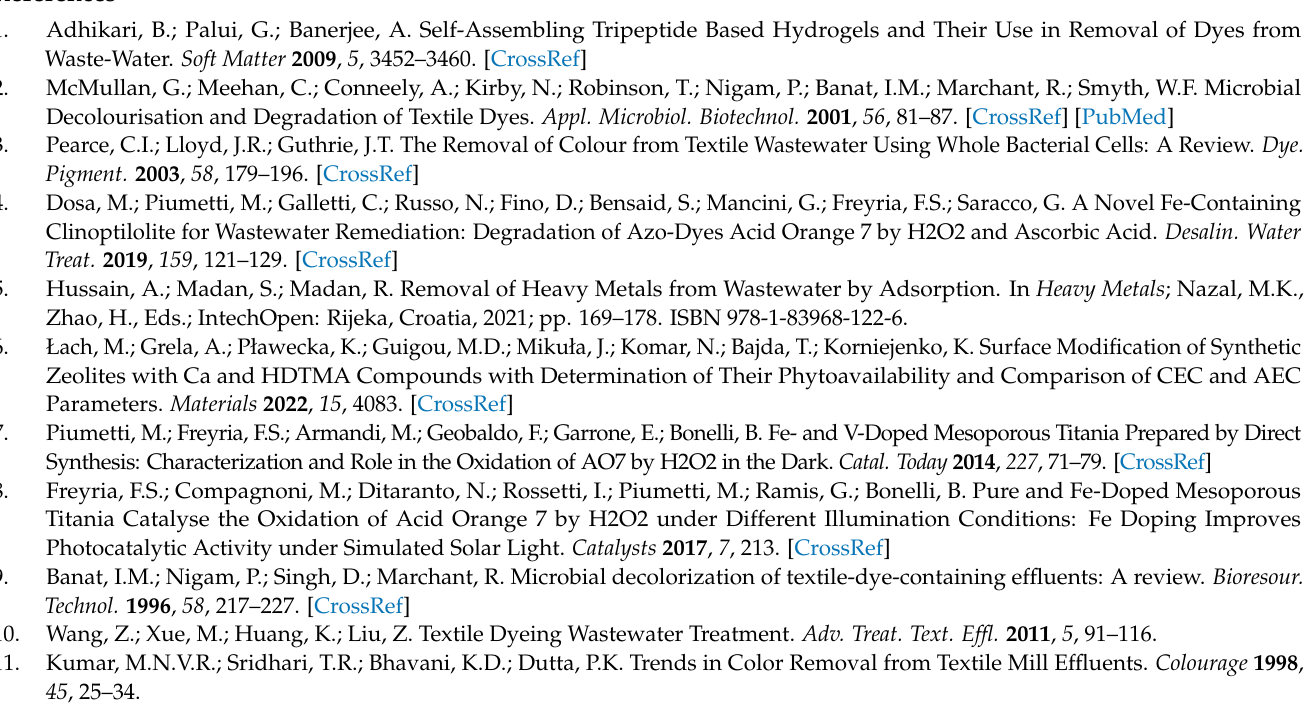
trations; Figure S3: Methylene Blue adsorption capacity at 250 ppm on Clinoptilolite and Activated Charcoal; Table S1: QPA results obtained with Clinoptilolite; Table S2: Average costs of Activated Charcoal; Table S3: Comparison of adsorption performance between Clin and other adsorbents in the literature toward different